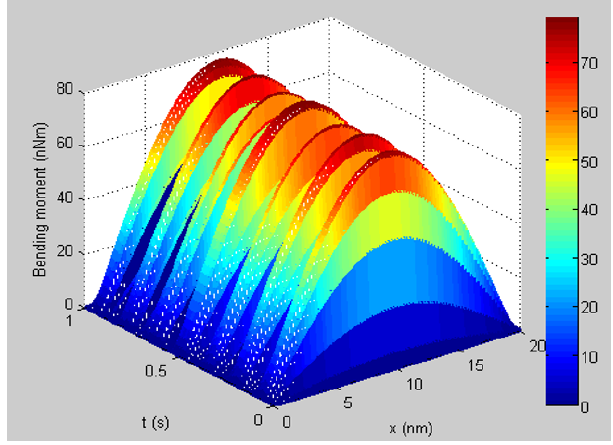
Figure 11. Bending moment Diagram of the SWCNT for mode 1